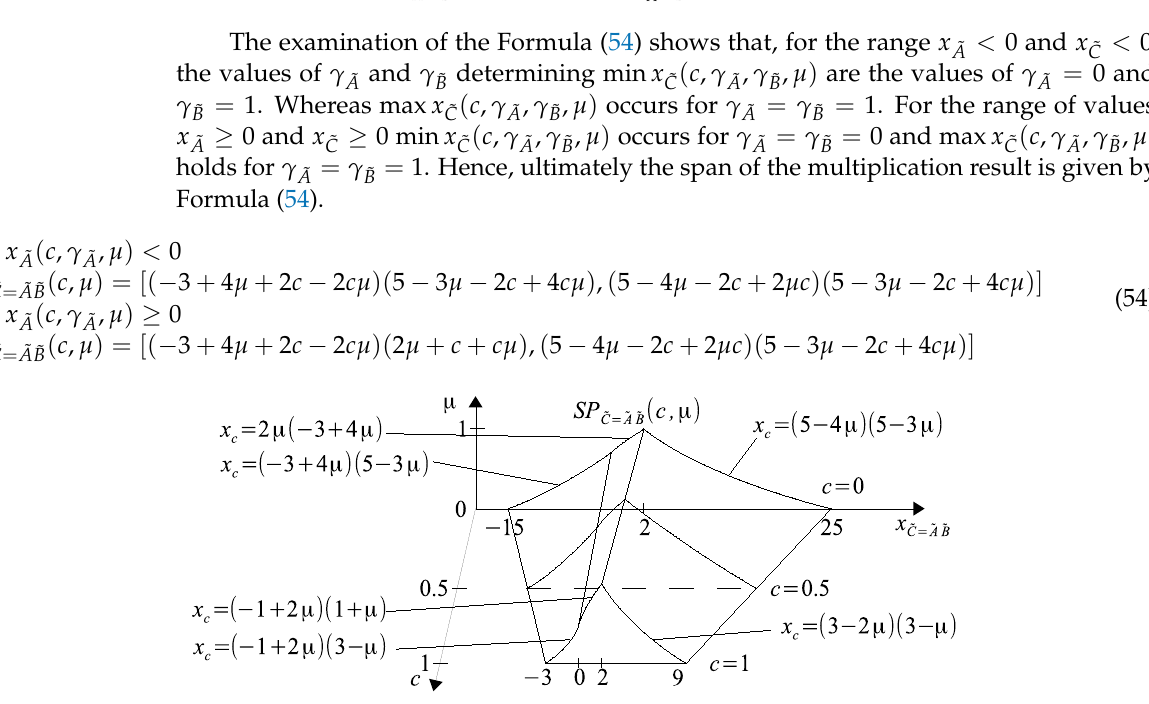
( c , µ ) of the result of the multiplication of T2FNs ˜ A and ˜ B with which the Figure 29. Span SP ˜ C = ˜ A ˜ B number ˜ A contains zero. On the left border of the function span, there is an inflection line of the = function corresponding to x ˜ C